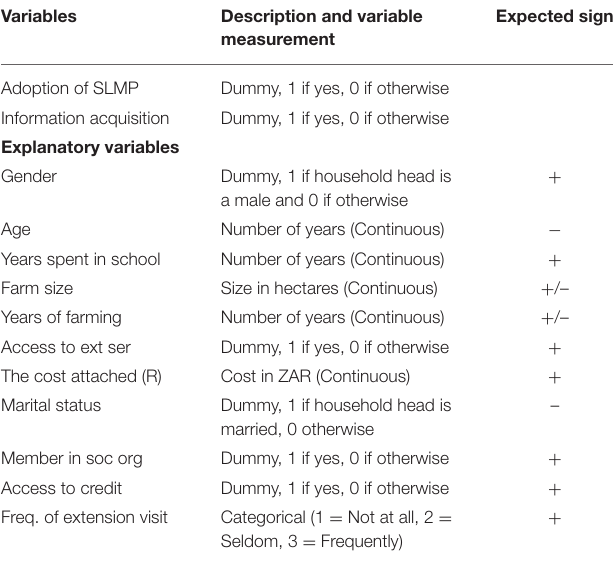
TABLE 2 | Variables used in the model and their measurements.